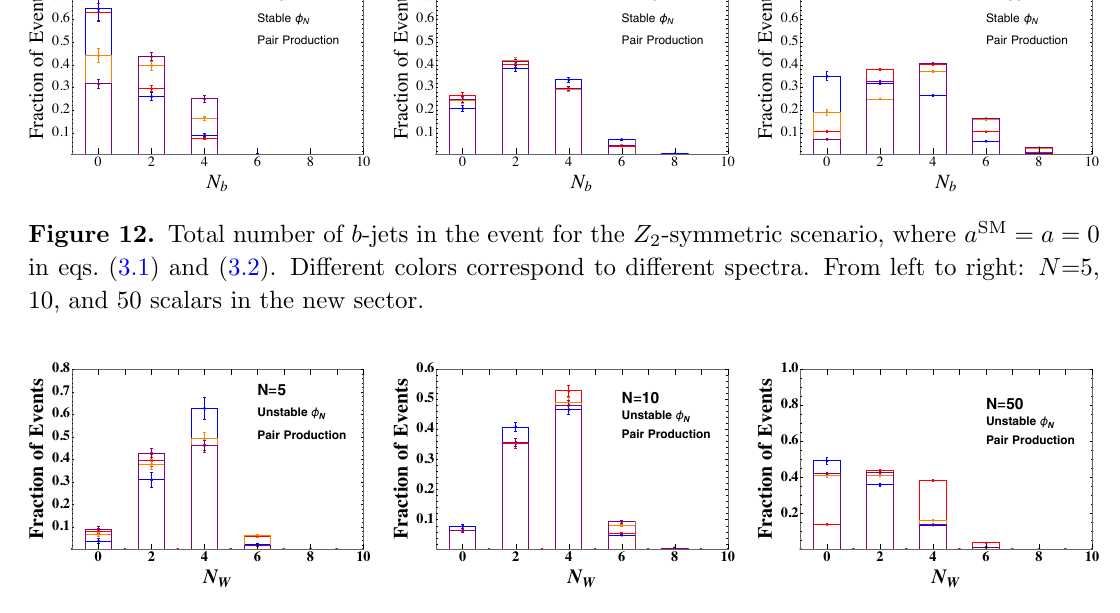
Figure 13. Total number of W bosons in the event in the scenario where all couplings in eqs. (3.1) and (3.2) are present and pair production dominates. Di(cid:11)erent colors correspond to di(cid:11)erent spec- tra. From left to right: N =5, 10, and 50 scalars in the new